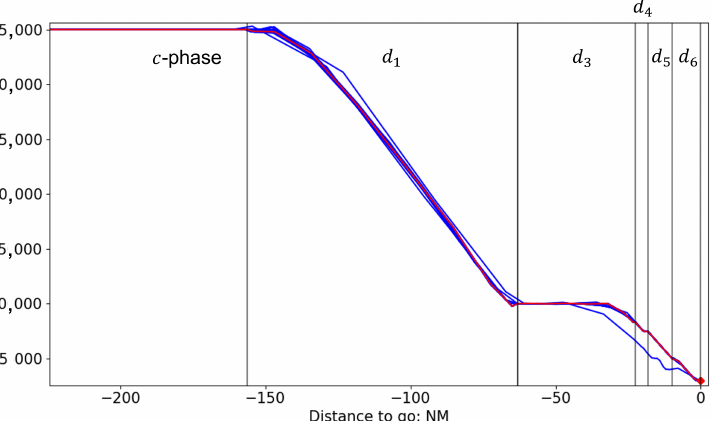
Figure 7. Trends of u and v along the robust trajectory for each weather scenario. The components are positive for west-to-east wind and south-to-north wind, respectively.